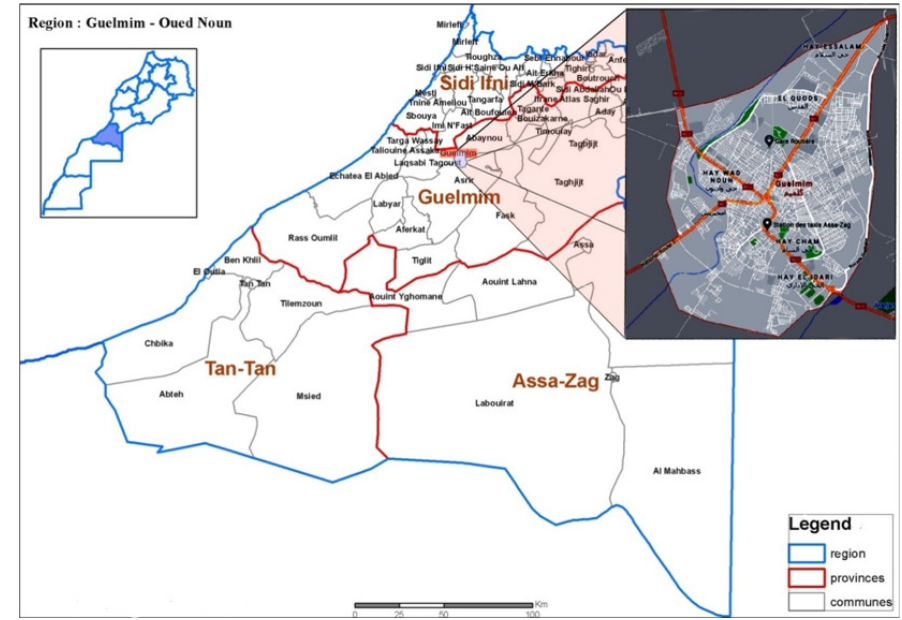
Figure 1. Map of Guelmim province and limit of the study area Source: High Commission for planning - Regional Directorate of